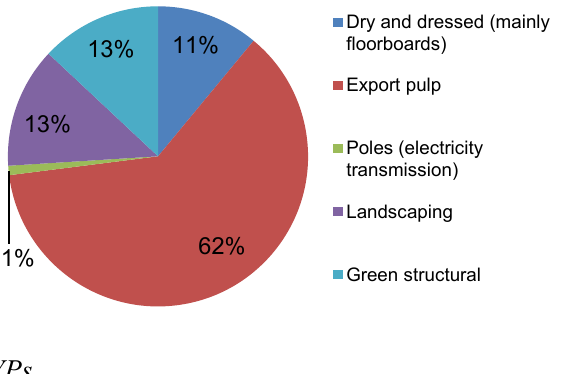
Figure 7. Product mix obtained from the South Coast “ production ” forests.